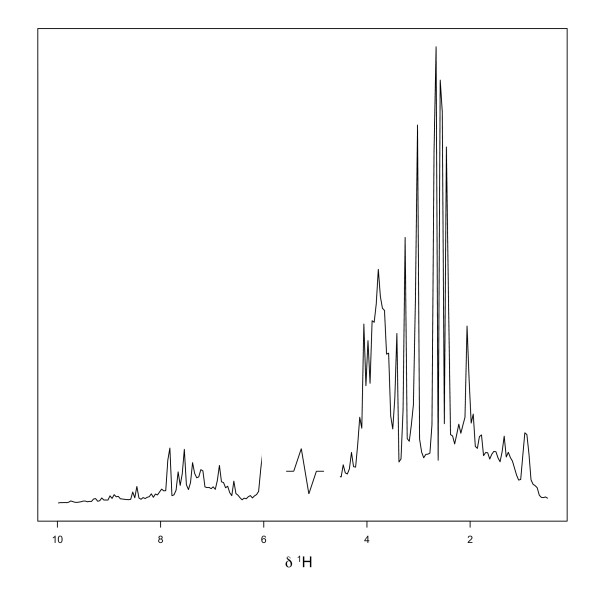
Typical integrated 1H NMR spectrum from the HgCl2 data set.